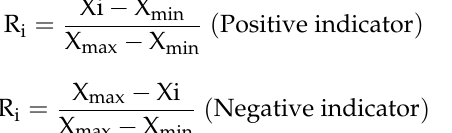
Table 1. The measurement indicator system of URID and the summary statistics of variables.